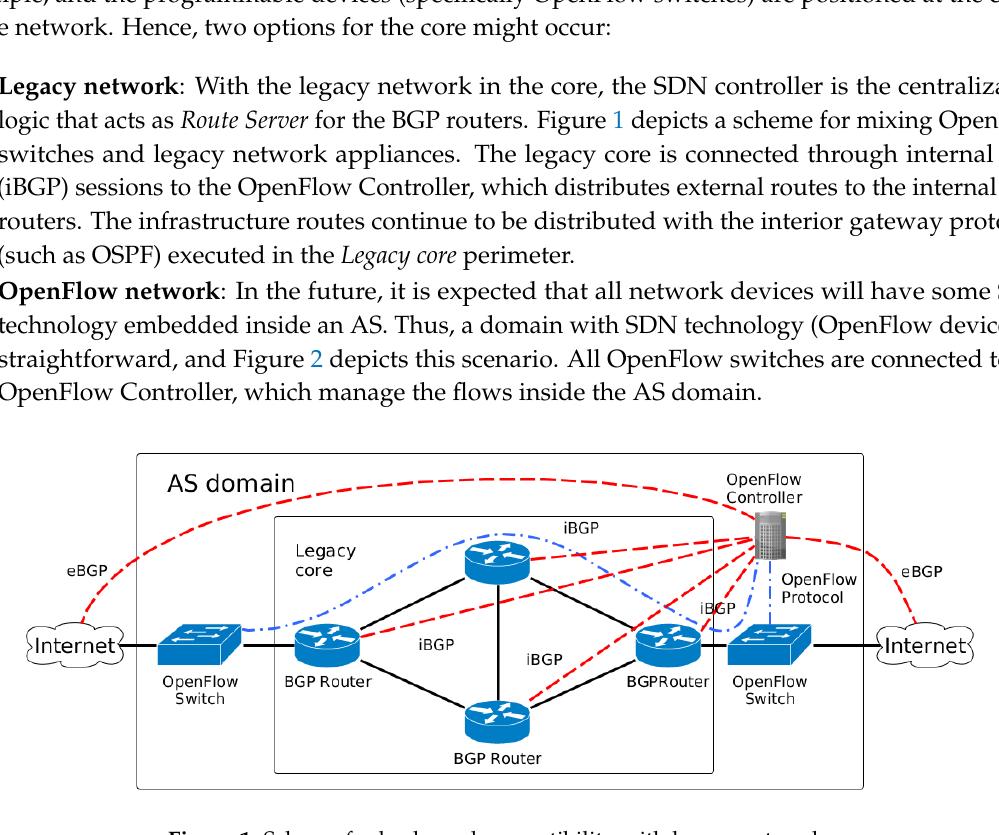
Figure 1. Scheme for backward compatibility with legacy